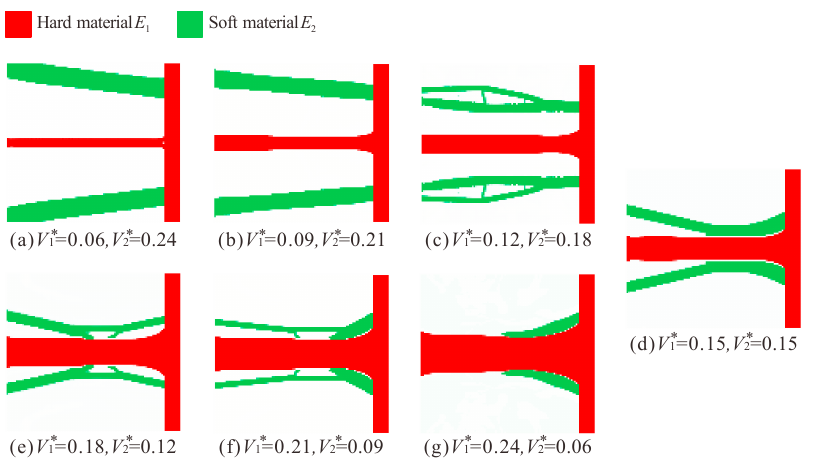
Figure 9. Topology optimization results of multi-material flexure hinge for different volume fraction combinations ( E 1 = 71 GPa, E 2 = 1 GPa).